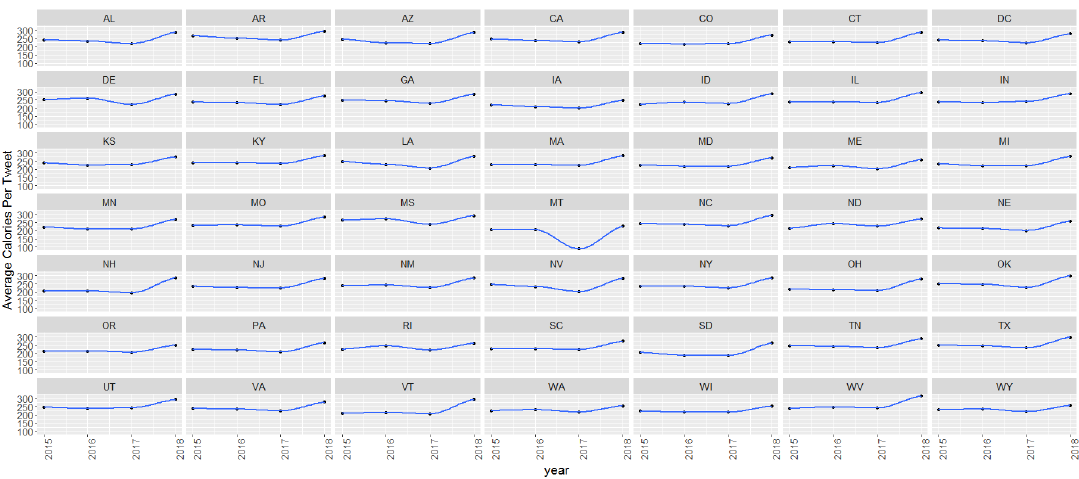
Figure 4. Temporal trends in average calories per tweet by state, Twitter 2015–2018.